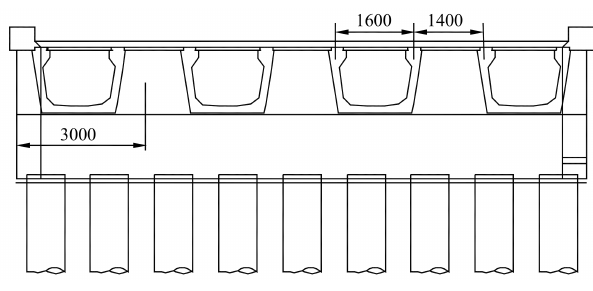
Figure 3. Profile of Thompson